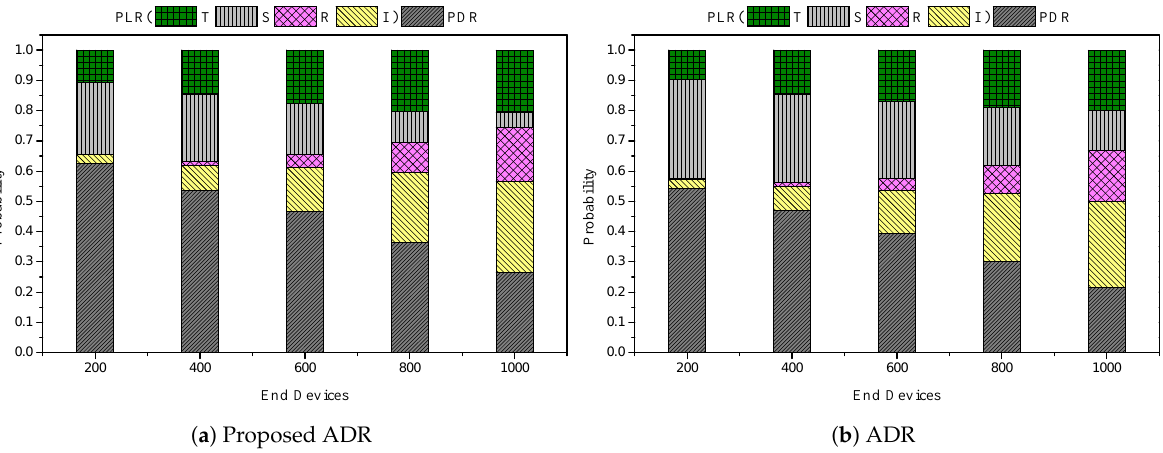
Figure 6. Analysis of PDR and PLRs.